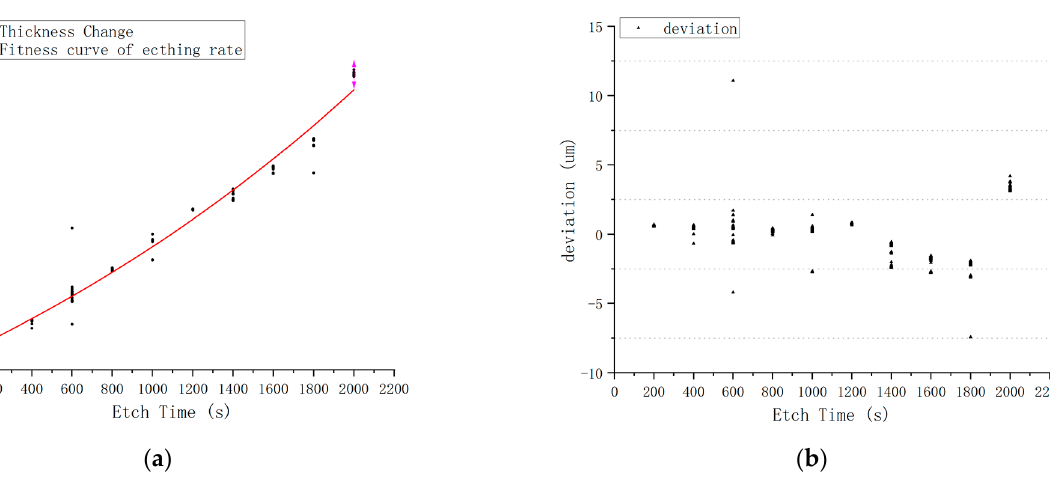
Figure 9. Etching rate of BOE solution at 60 °C: ( a ) etching rate; ( b ) deviation. In Figure 10a, data are also taken from a production line and are compared to the fitness curve. There are 2992 pieces of quartz blanks used to plot this graph, and the etch solution was anhydrous etching solution. In Figure 10b, the difference in the calculated curve vs. the actual data points is plotted.